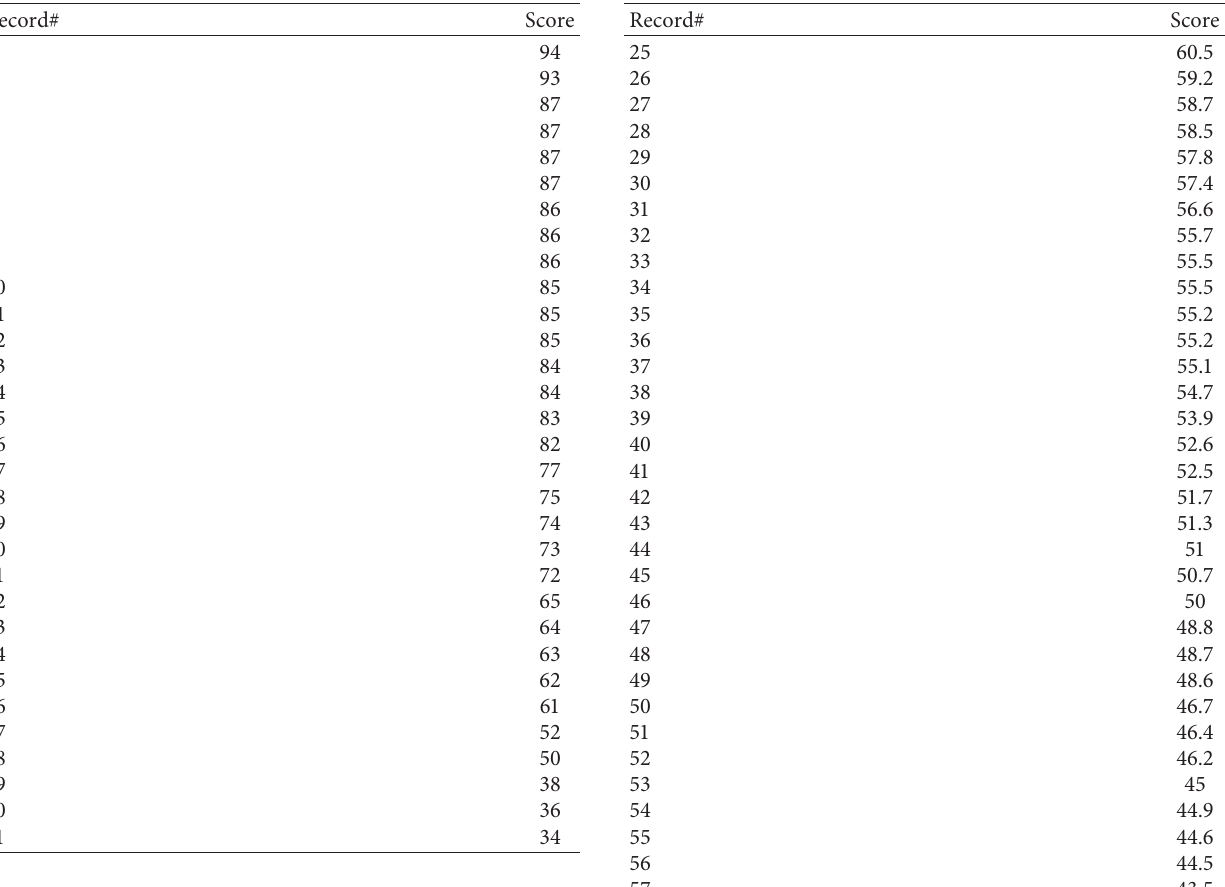
Table 3: Sorted scores of SD − data set.